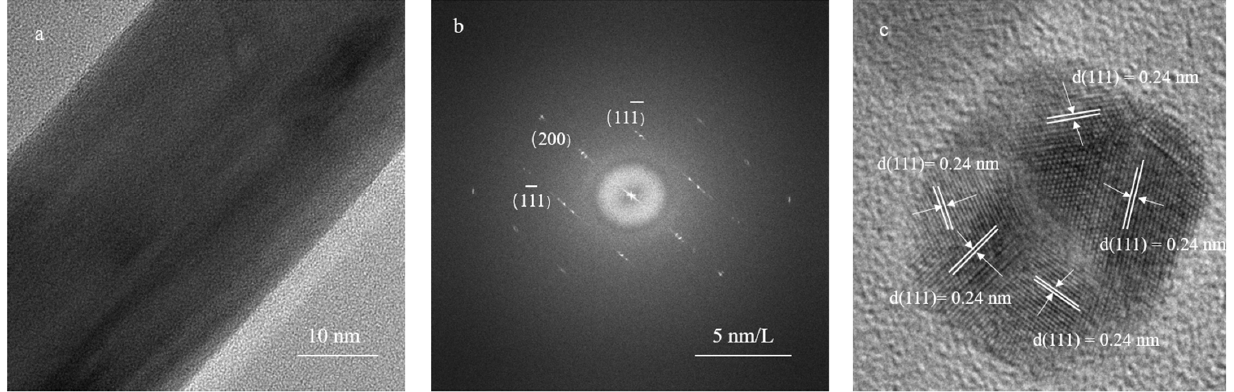
Figure 7. ( a ) A selected transmission electron microscope image. ( b ) A SAED image of region ( a ). ( c ) An image of a twinned crystal species in the prereaction period.